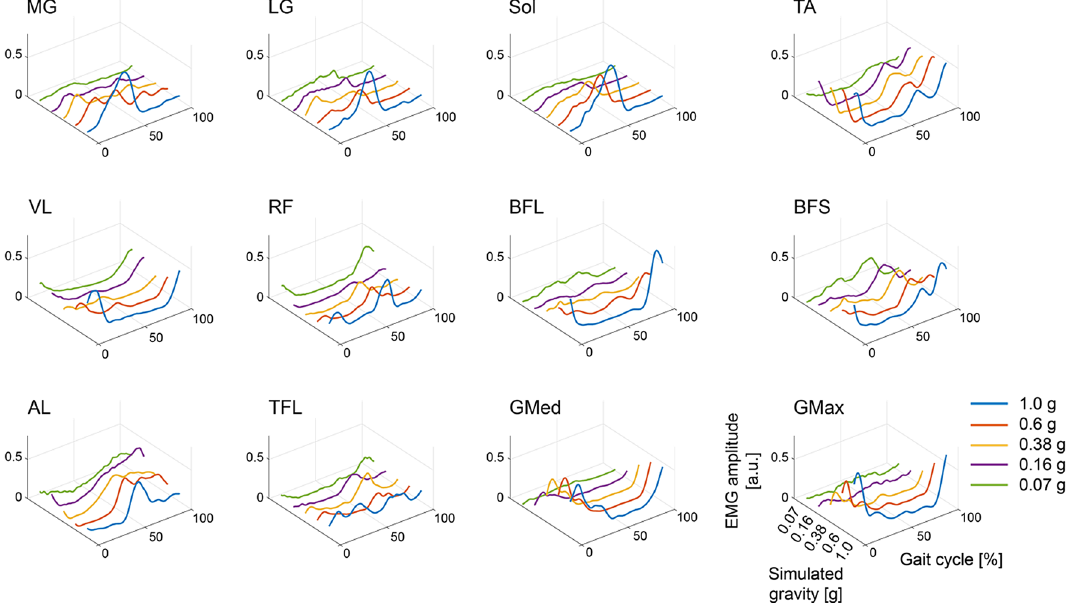
Figure 2. Muscle activity across each gravity. Rectified and filtered electromyographic (EMG) activity normalized to the peak activity in a gravity condition of 1 g are shown. The activation profiles for the individual gravity levels (1 g, 0.6 g, 0.38 g, 0.16 g, and 0.07 g) are distinguished by colour. Each data point is an average across all participants and 10 gait cycles (from the onset of the right leg to the next; normalized to 200 time bins) at a walking speed corresponding to the Froude number ( Fr ) ~ 0.25. The abbreviations of the muscles are as follows: medial head of the gastrocnemius muscle (MG), lateral head of the gastrocnemius muscle (LG), soleus (SOL), tibialis anterior (TA), vastus intermedius (VL), rectus femoris (RF), biceps femoris (long head, BFL), biceps femoris (short head, BFS), adductor longus (AL), tensor fasciae latae (TFL), gluteus medius (GMed), and gluteus maximus